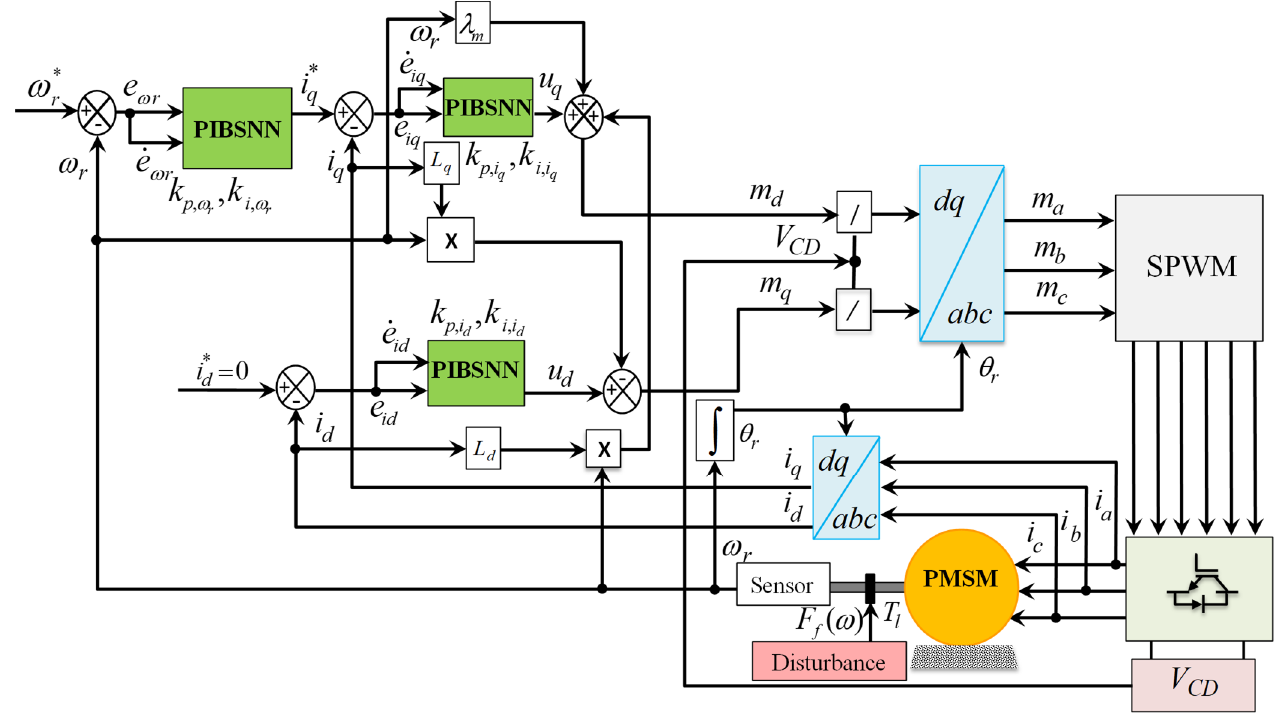
Figure 1. Block diagram of neuroadaptive robust speed control for PMSM servo drives with rotor failure.